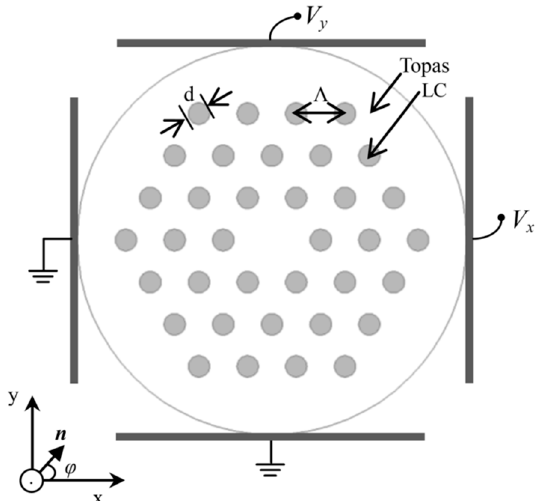
Figure 1. Cross section of the liquid-crystal microstructured optical fiber (LC-MOF) and diagram for arbitrarily controlling the orientation of the nematic director in the x–y plane by two orthogonal sets of electrodes with voltage, V x and V y .